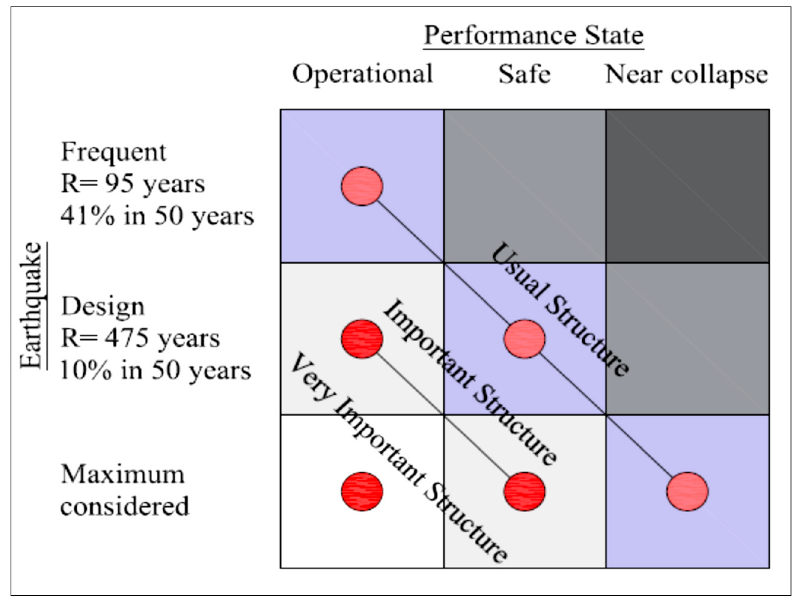
Figure 1. Requirements for structural performance during different types of earthquake in accord- ance with EN 1998-1 [6] . with EN 1998-1